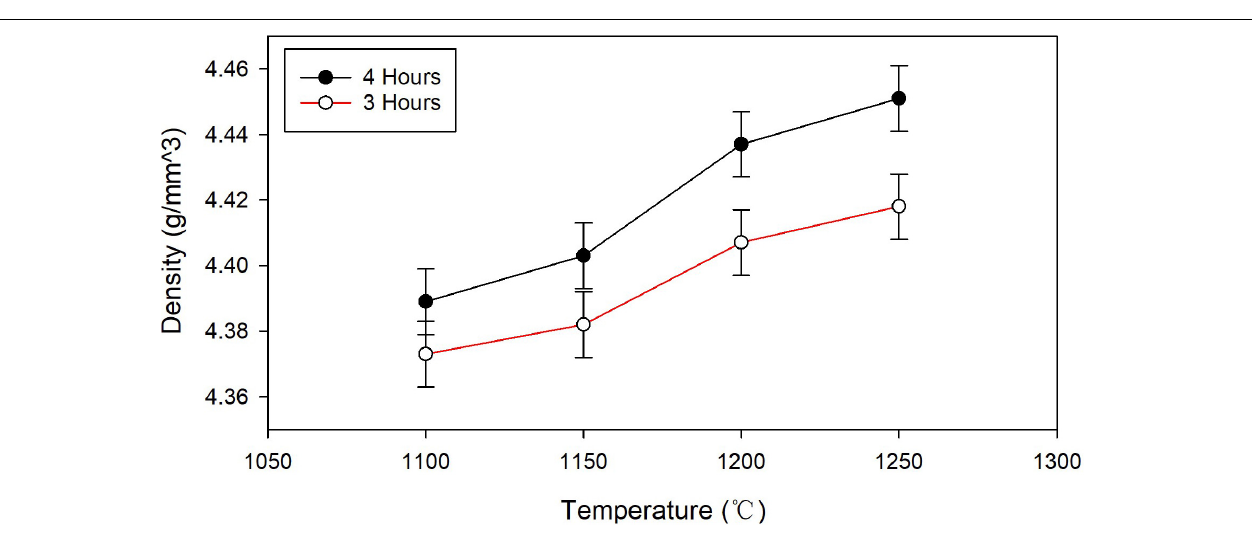
FIGURE 5 | Density of the Ti80 materials depending on sintering temperature and